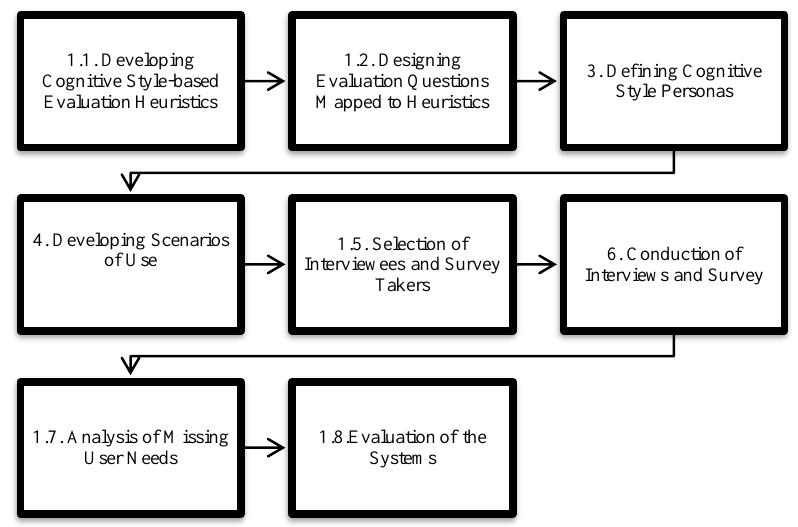
Fig. 2. Proposed lecturing platform usability evaluation